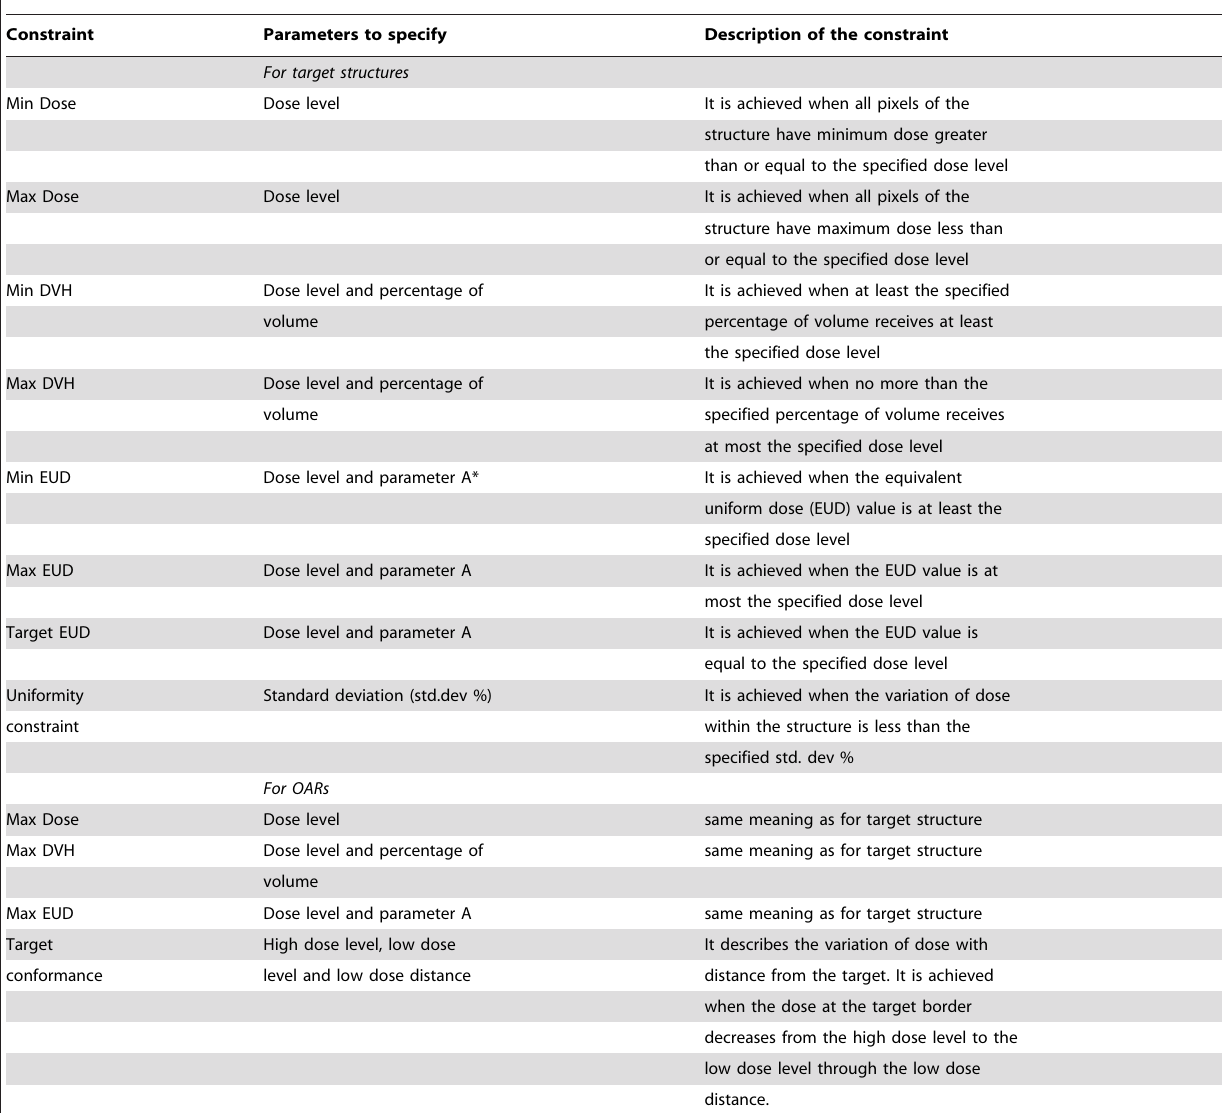
Table 2. Details of optional constraints available for targets and OARs.